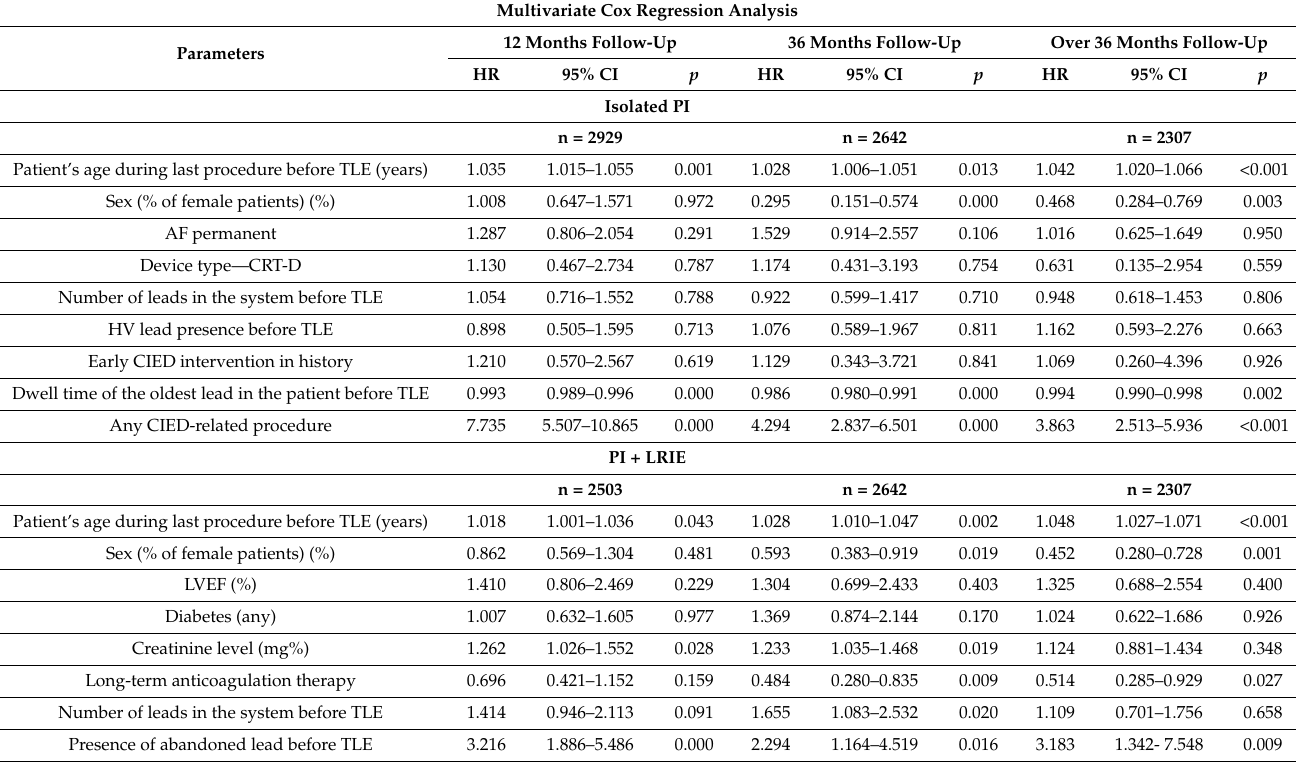
Table 4. Multivariate Cox regression analysis of risk factors of occurrence of different types of CIED-related infections in particular time